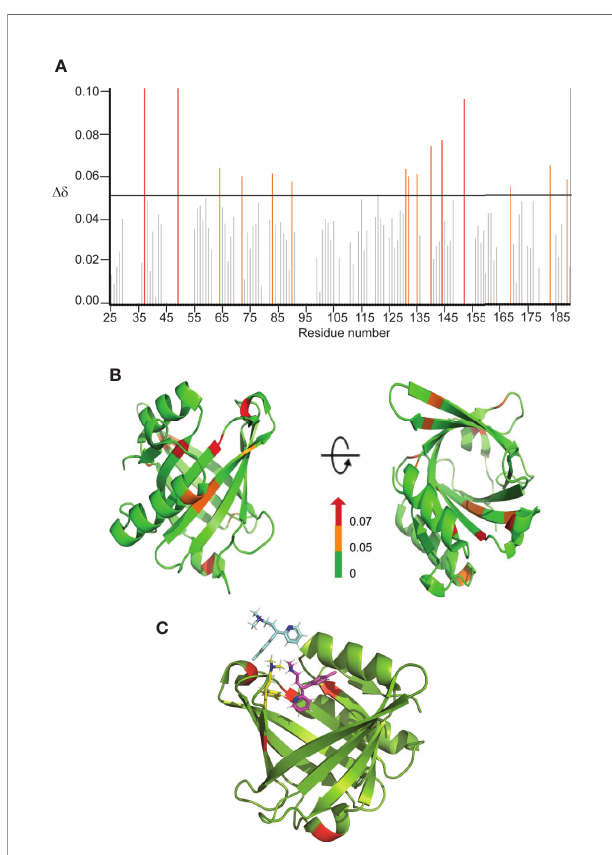
FIGURE 3 | Binding sites characterization of CPM on L-PGDS, as determined by NMR titrations. (A) The chemical shift perturbations ( Dd ) of backbone and amide groups of residues in L-PGDS induced by binding to CPM at a molar ratio of 1:4 (protein:drug). (B) Mapping of chemical shift perturbations ( Dd ) on L-PGDS crystal structure (PDB code: 4IMN) in the presence of CPM (1:4) (protein:ligand). Red and orange show Dd >0.07 and 0.05 < Dd < 0.07, respectively. In the panels, left and right images are the front and top views of L-PGDS (PDB code: 4IMN) in solution, respectively. (C) Model of three CPM molecules (blue, yellow and magenta) docking onto L-PGDS (green) obtained from online protein-ligand docking platform, HADDOCK (van Zundert et al.,